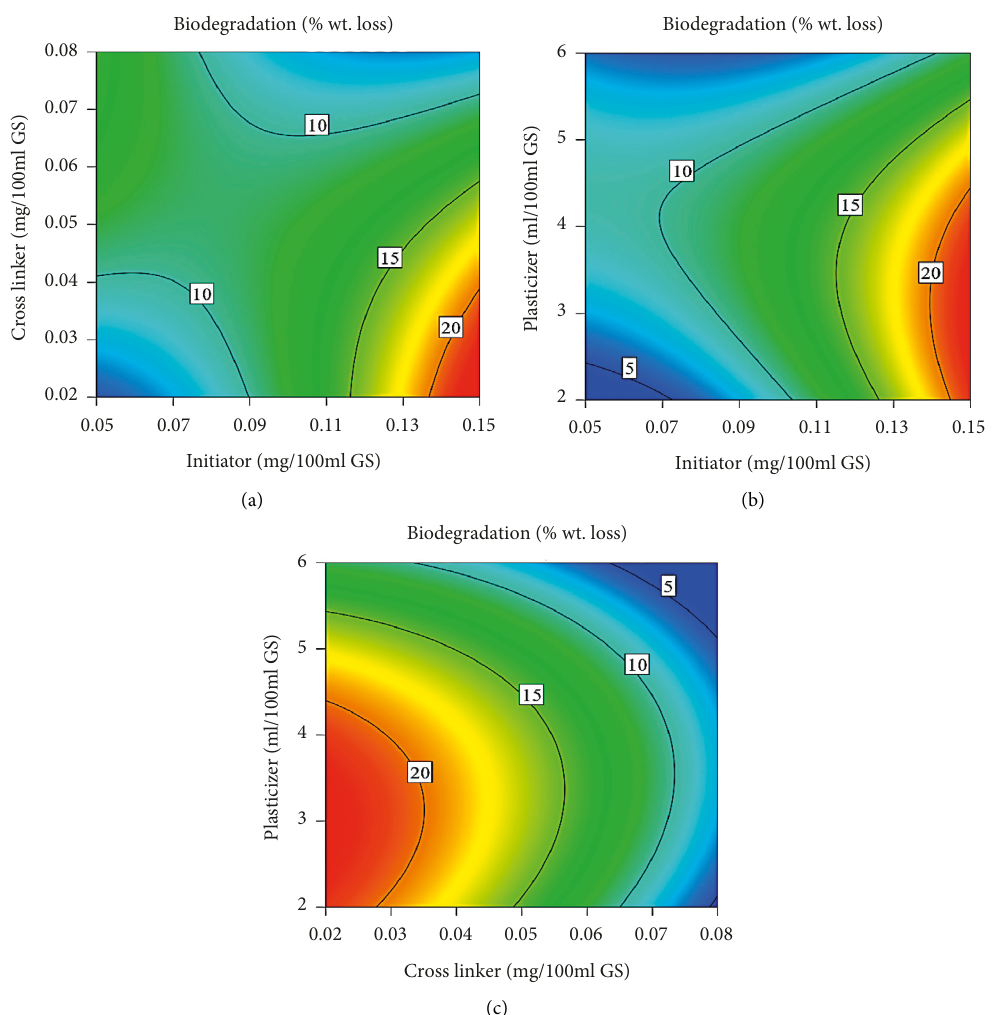
Figure 1: (a) Combined effects of initiator and crosslinker on biodegradation at the optimum value of plasticizer concentration (2.88mL/ 100mL GS). (b) Combined effects of initiator and plasticizer concentration on biodegradation at the optimum value of crosslinker (0.02 mg/ 100mL GS). (c) Combined effects of crosslinker and plasticizer concentration on biodegradation at the optimum value of initiator (0.15 mg/ 100mL